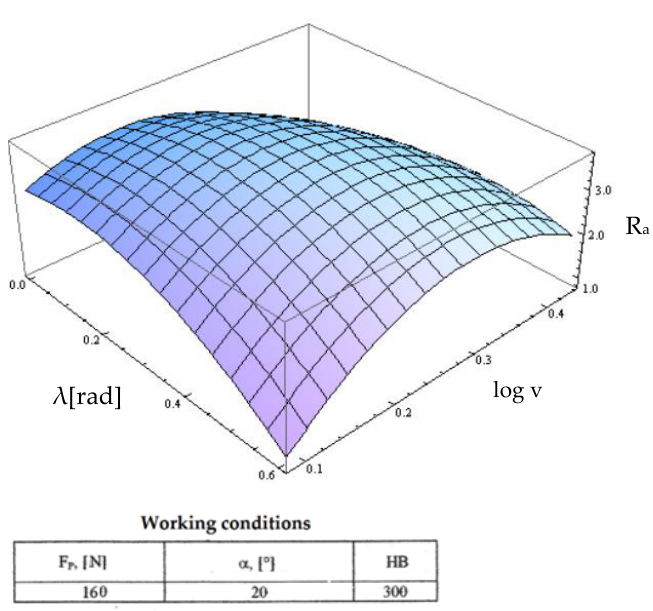
Figure 17. Influence of the inclination angle and cutting speed v on roughness R a.